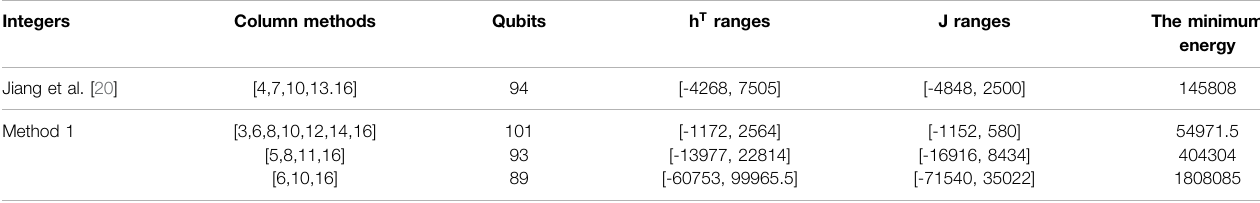
TABLE 4 | Different column methods for the integer